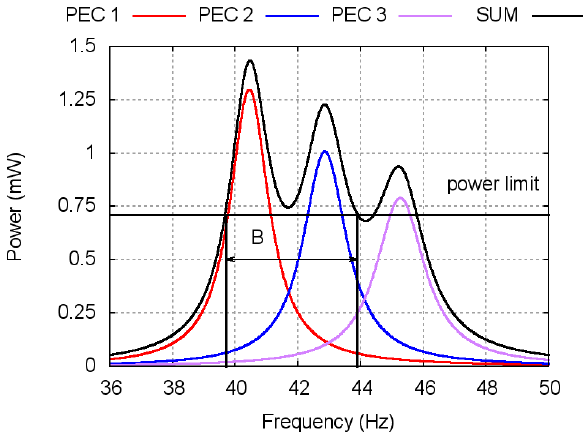
Figure 6. Simulated bandwidth of the array with large detuning ∆ f = 2.4 Hz.